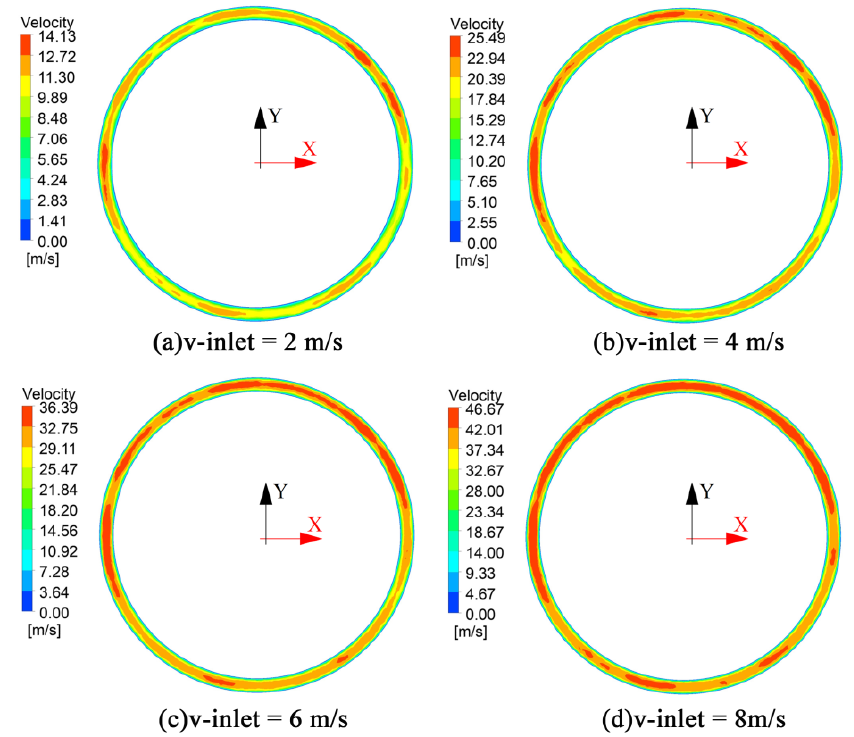
Figure 6. Distribution of gas flow velocity at the gas outlet boundary of the double gas chamber die.